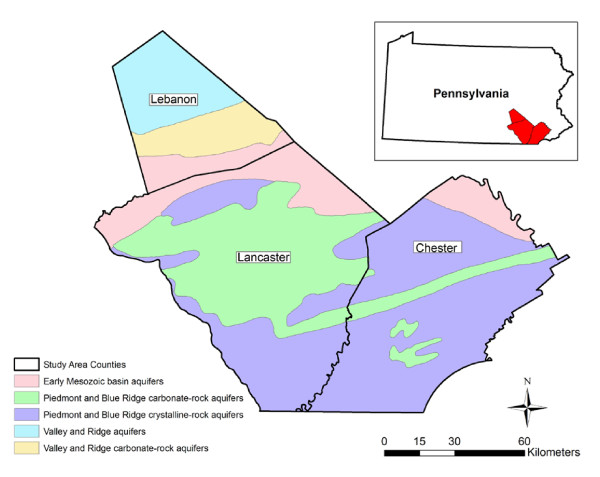
Principle aquifers in the three study area counties in southeastern Pennsylvania. Data from Principal Aquifers of the 48 Conterminous United States, Hawaii, Puerto Rico, and the U.S. Virgin Islands: U.S. Geological Survey. Madison, WI; 2003